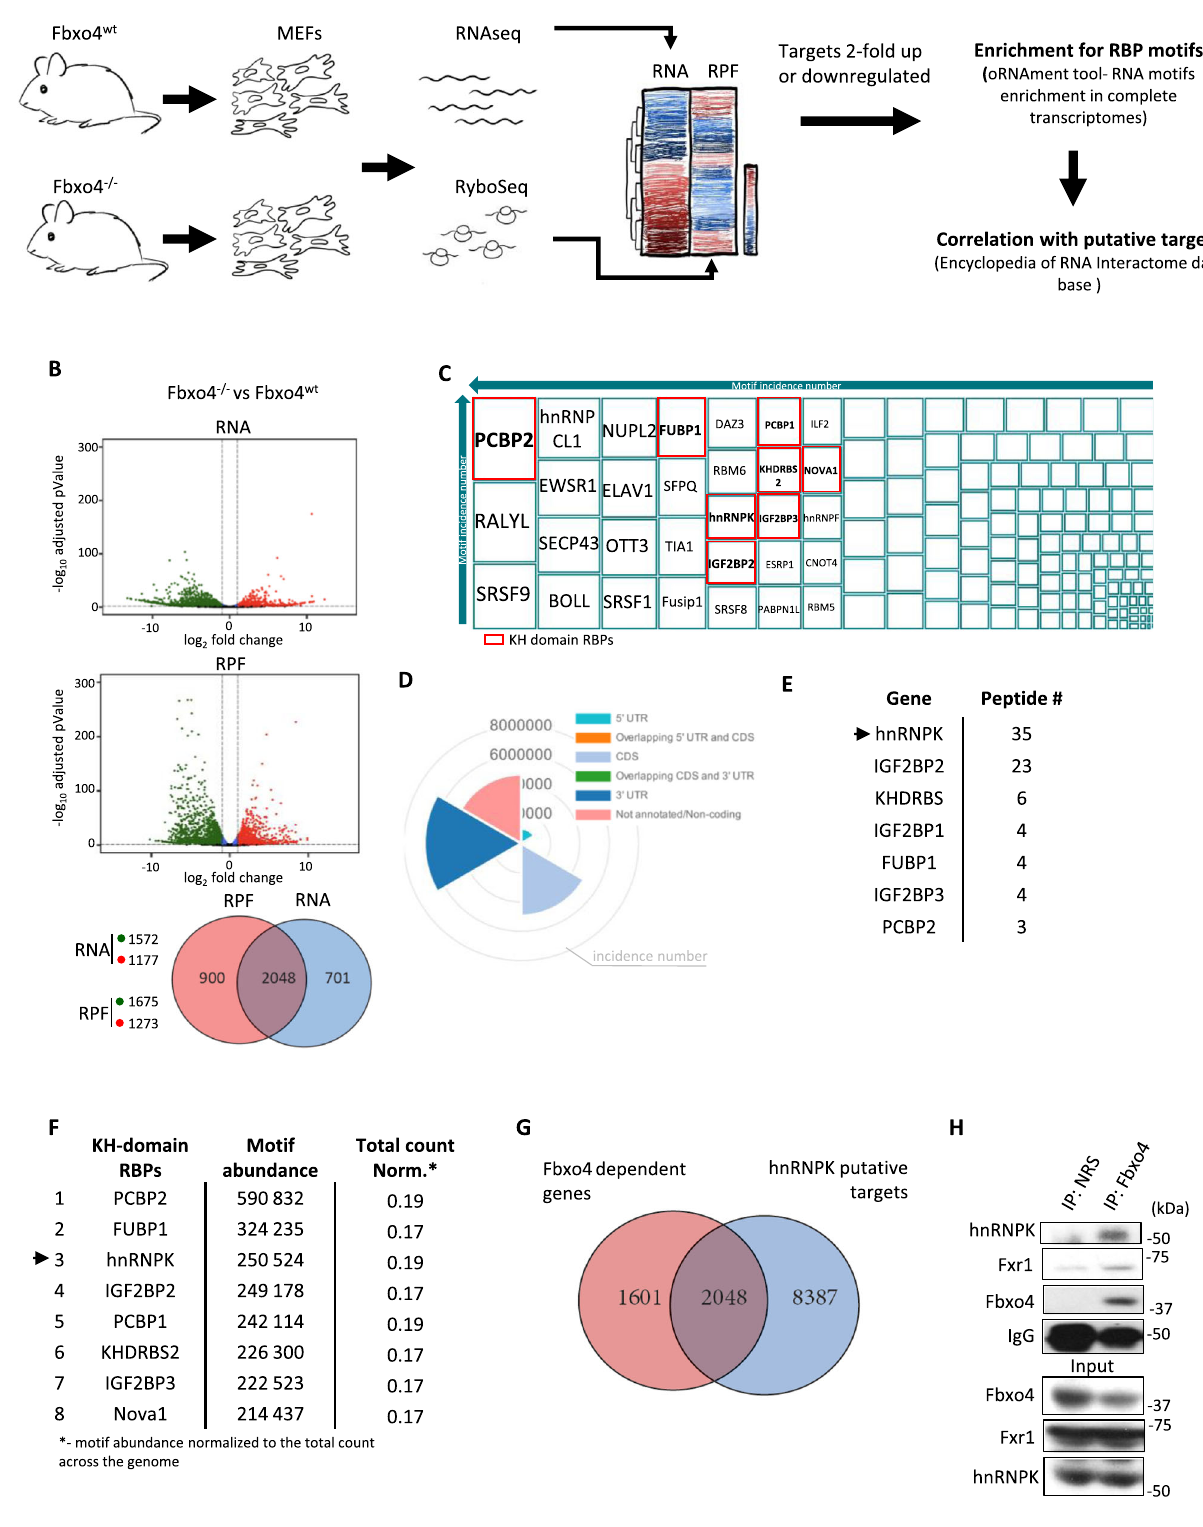
(Fig. 3B) or re-introduction of Fbxo4 wt (Fig. 3C). Overexpression of ubiquitin-refractory hnRNPK mutants but not hnRNPK wt increased c-Myc (Fig. S3D, E) demonstrating that both Fbxo4 and hnRNPK con- tribute to c-Myc